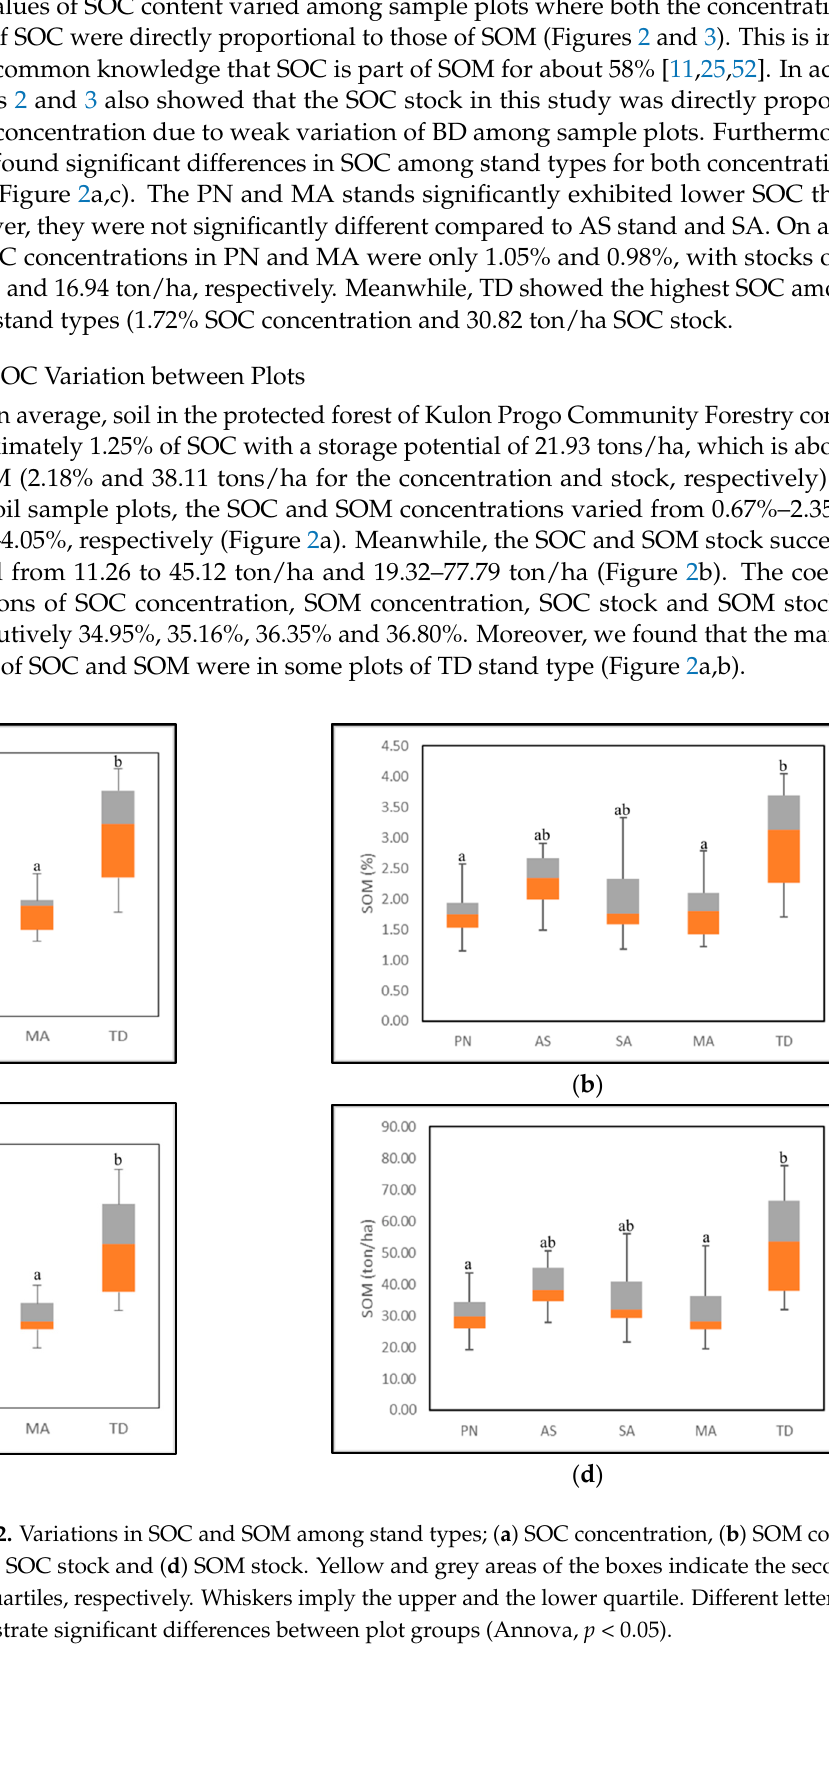
( b ) Figure 3. Between plot variations in SOC and SOM; ( a ) concentration (%), ( b ) stock (ton/ha). Blue lines indicate SOC, and yellow lines indicate SOM.